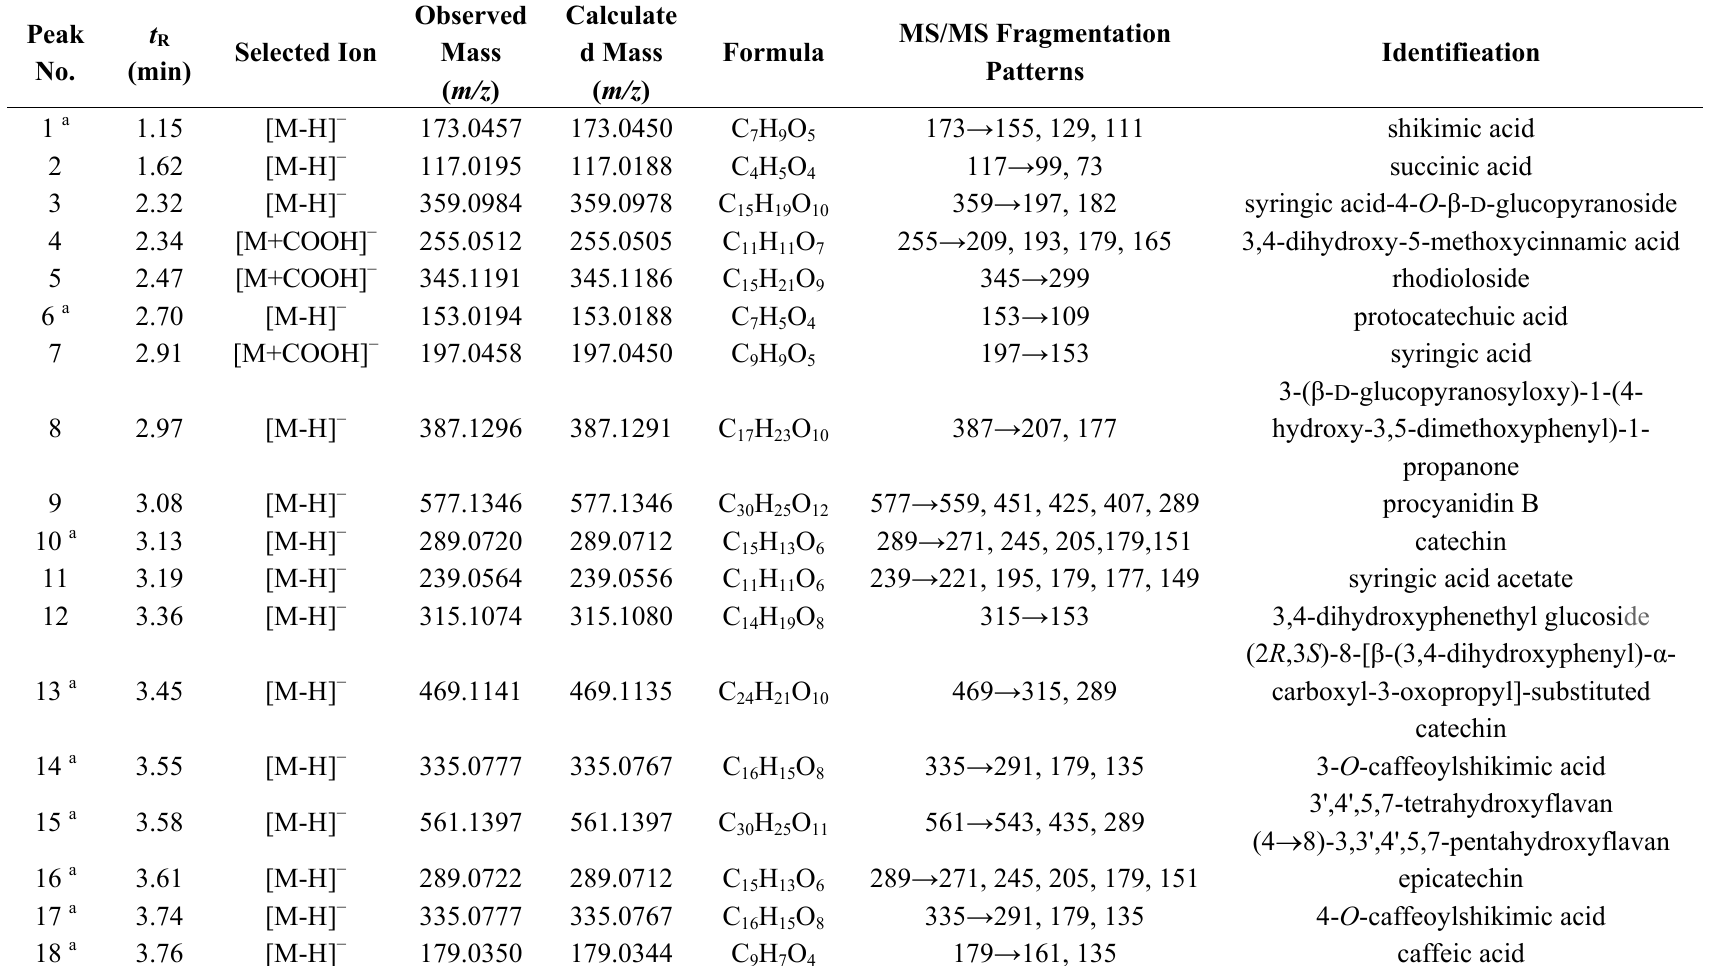
Table 1. Identification of the chemical constituents of Smilacis glabrae by UHPLC-ESI-MS n analysis.